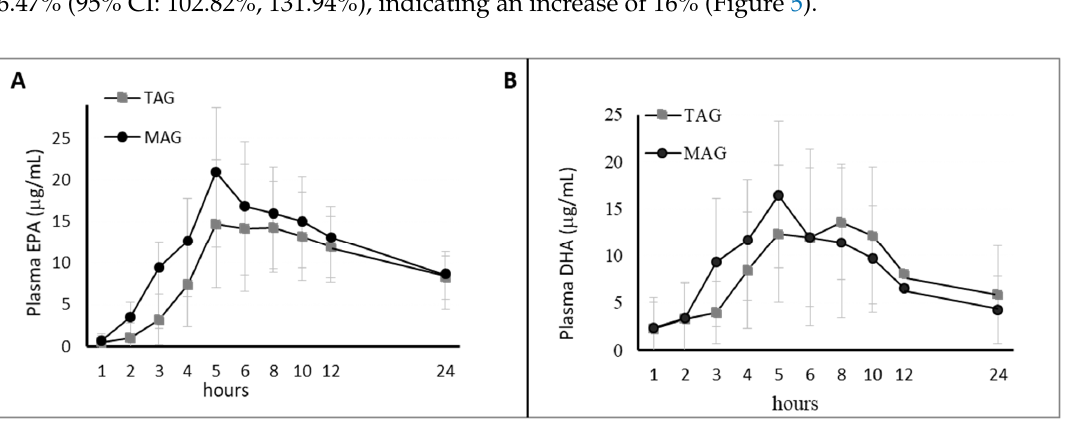
Figure 5. Clinical trial B. Acute e ff ect: Pharmacokinetic results (baseline-adjusted), EPA ( A ) + DHA ( B ) in Plasma, AUC over 24 h postprandial (upper panel). Results are expressed in ug*h/mL.